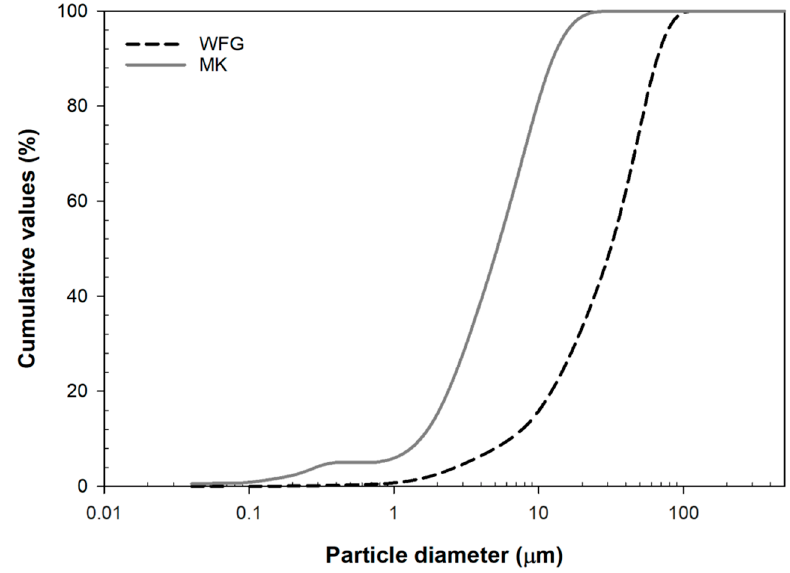
Figure 1. Cumulative particle-size distribution curves of the raw materials (MK and WFG).